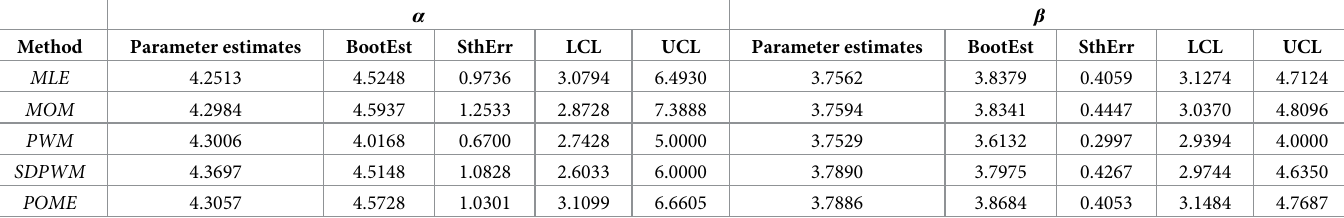
Table 4. Parameter estimates, standard error, length and coverage of a 95% confidence interval based on bootstrap resamples from the patient relief times.